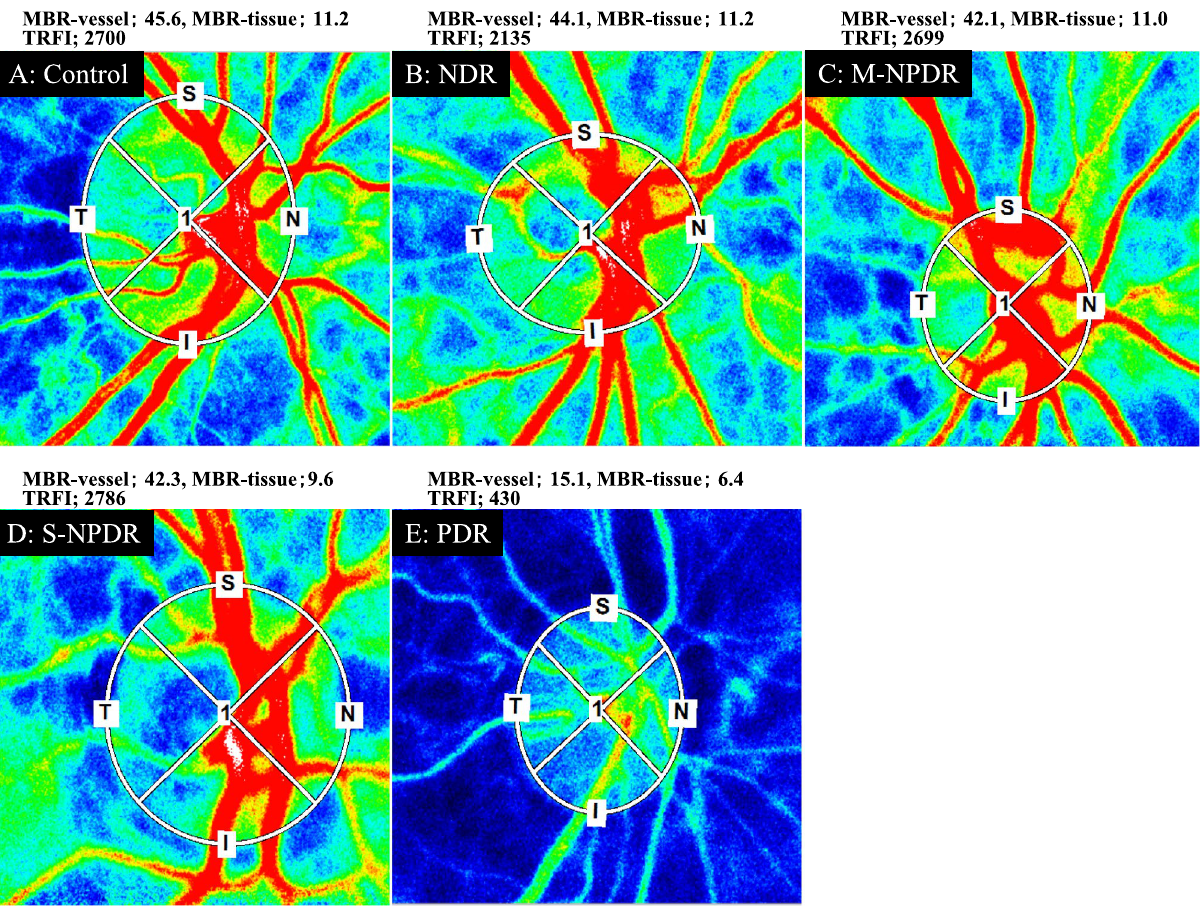
Figure 4. Representative composite color maps on the optic nerve head determined by LSFG at each stages of DR. Red color indicates a high mean blur rate (MBR), and blue color indicates a low MBR. Eyes in the control group ( A ); NDR group ( B ); M-NPDR group ( C ); S-NPDR group ( D ); and PDR group ( E ) are